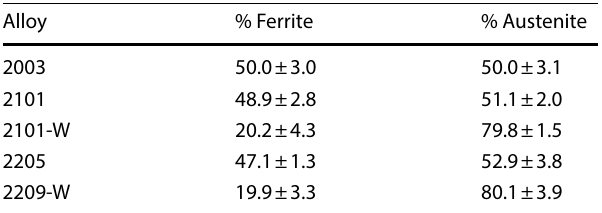
Table 3 Phase fraction for each DSS alloy at 10,000 h of thermal aging Alloy % Ferrite %